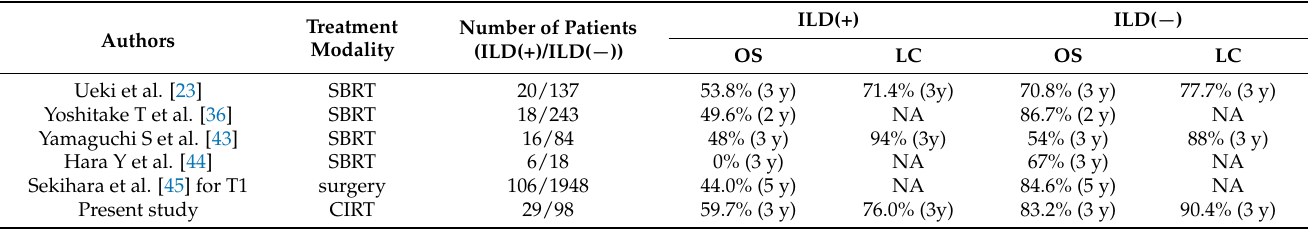
Table 5. Overall survival and local control in patients with or without interstitial